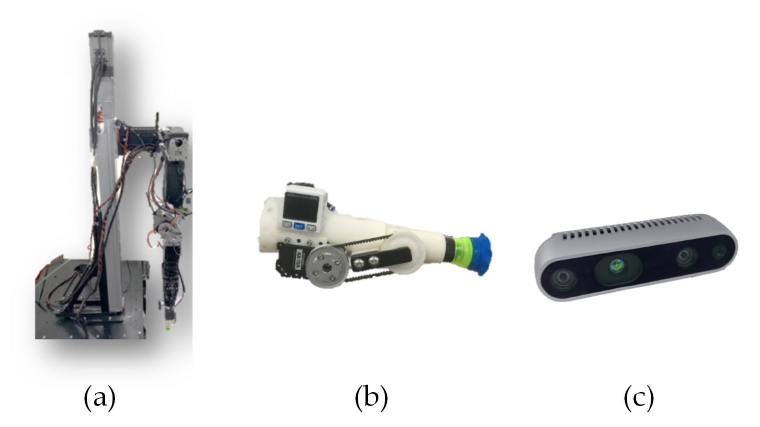
Figure 9. Three instruments used in the experiment: ( a ) laboratory-made 7-DoF manipulator; ( b ) laboratory-made vacuum suction cup; and ( c ) Intel® RealSense™ D435 RGB-D